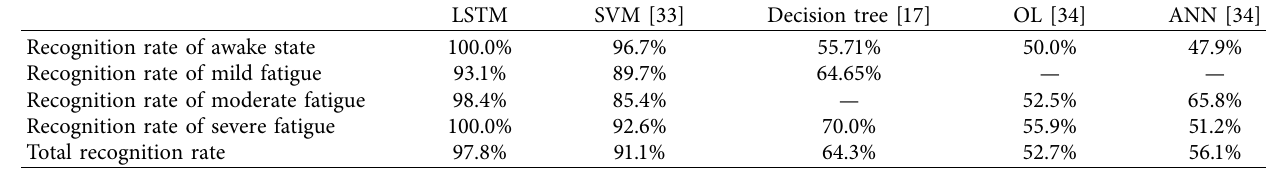
Table 7: Comparison of results between